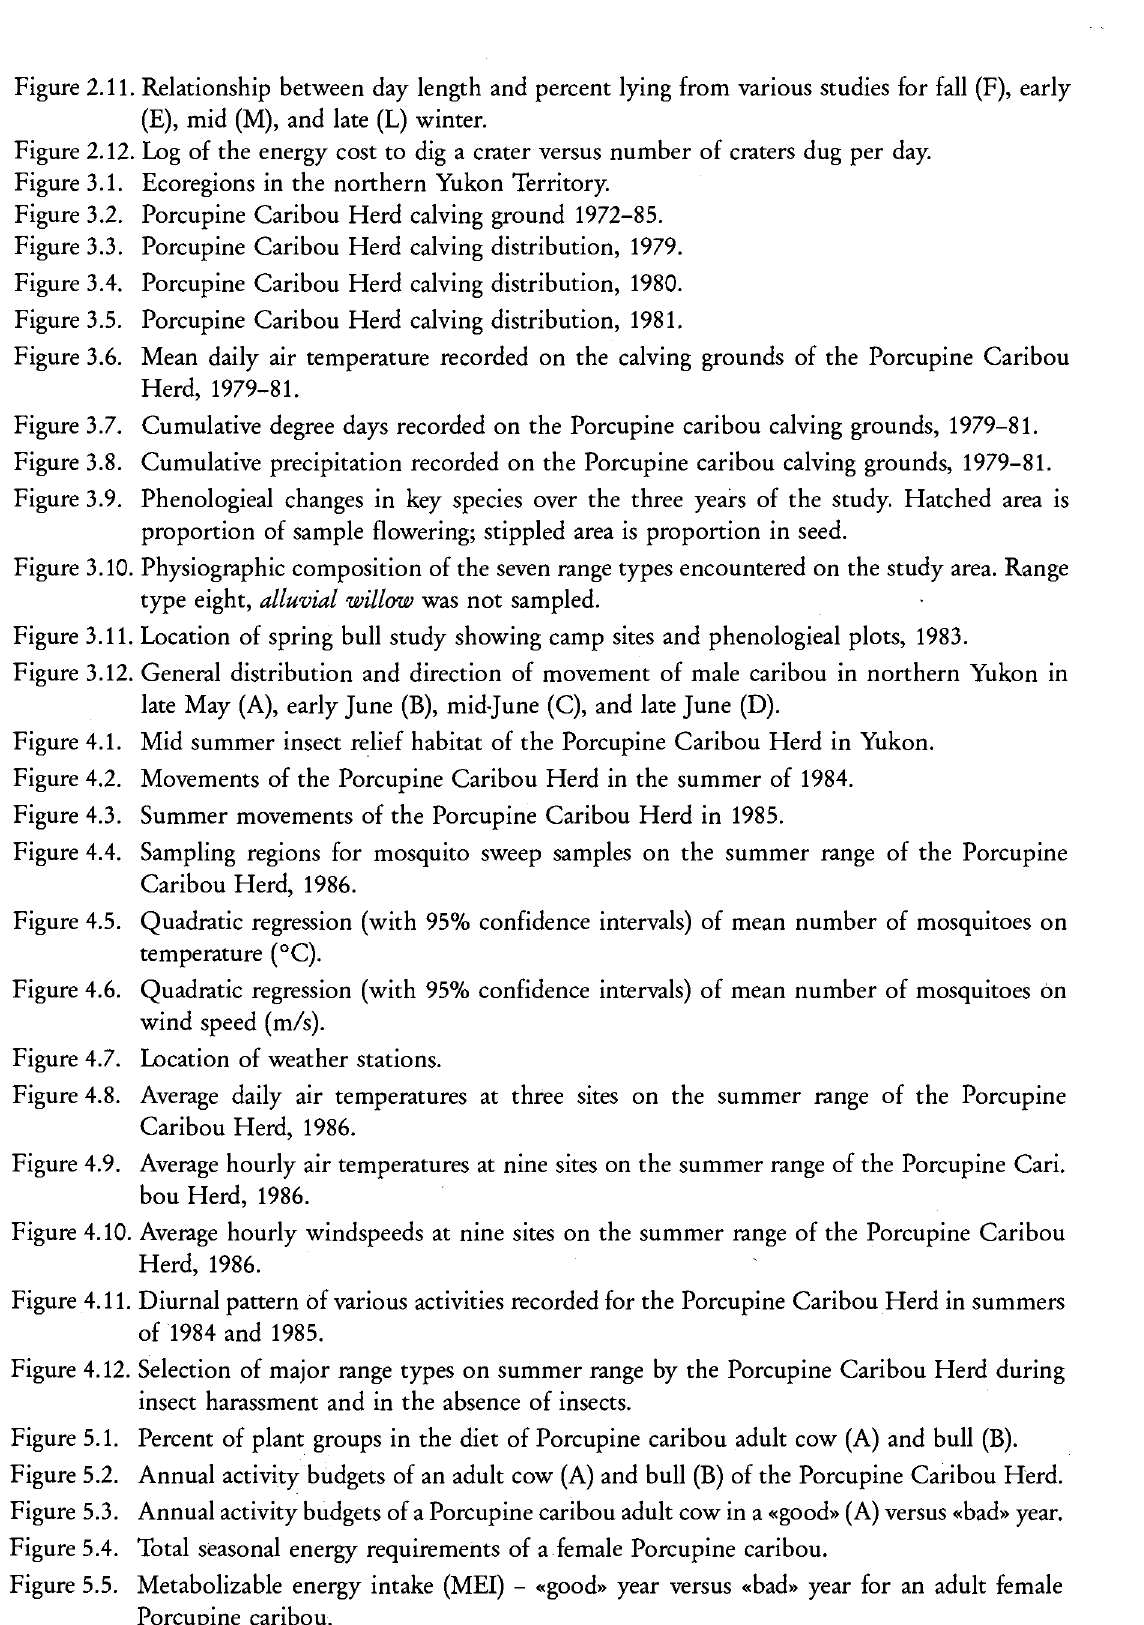
Figure 5.4. Total seasonal energy requirements of a female Porcupine caribou. Figure 5.5. Metabolizable energy intake (MEI) - «good» year versus «bad» year for an adult female Porcupine